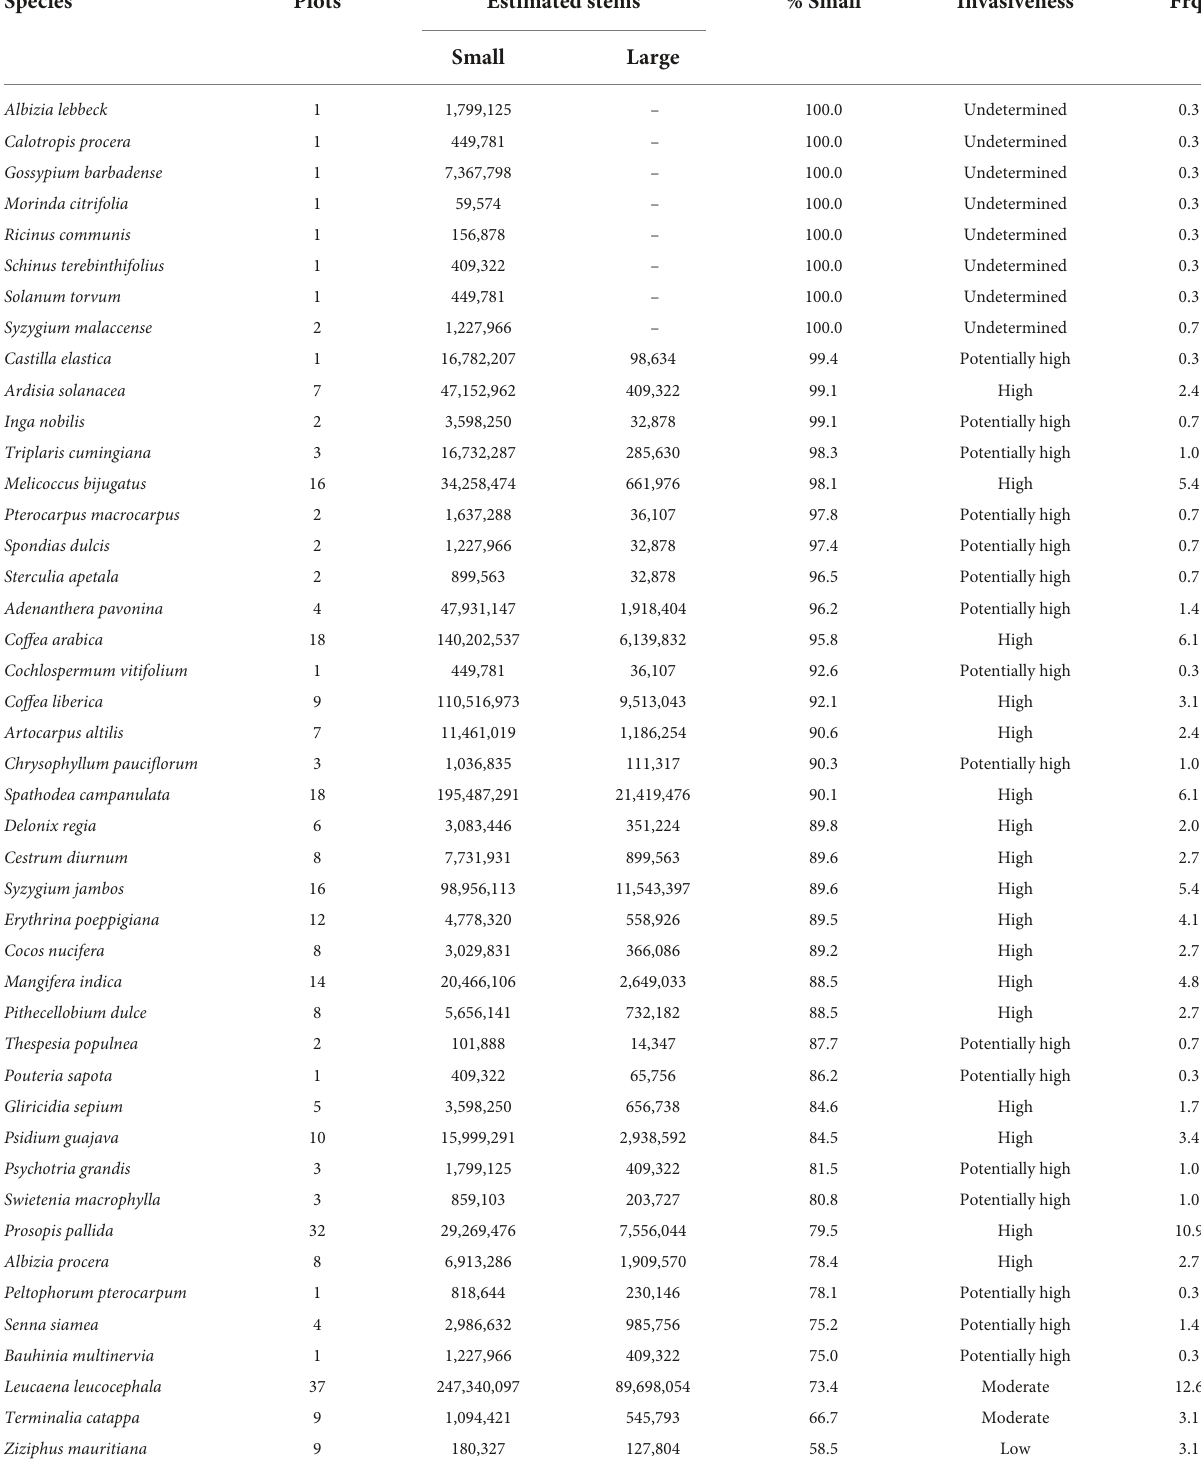
TABLE 3 Fifty-seven non-native tree species detected by the Forest Inventory and Analysis (FIA) program in Puerto Rico, along with the number of plots on which each was inventoried, the estimated number of small and large stems based on the FIA sample design, the percent of all trees within the small tree size class, the overall invasiveness assigned to the species based on its proportion of smaller trees, and the frequency (percent of plots in Puerto Rico) on which the species occurs. Species